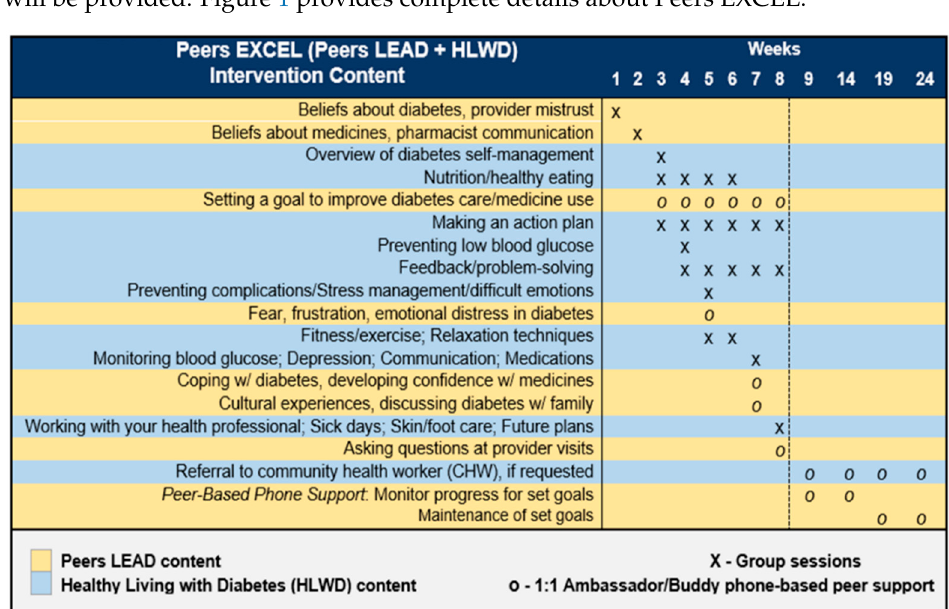
Figure 1. Peers EXCEL (Peers LEAD + HLWD) Intervention Content.